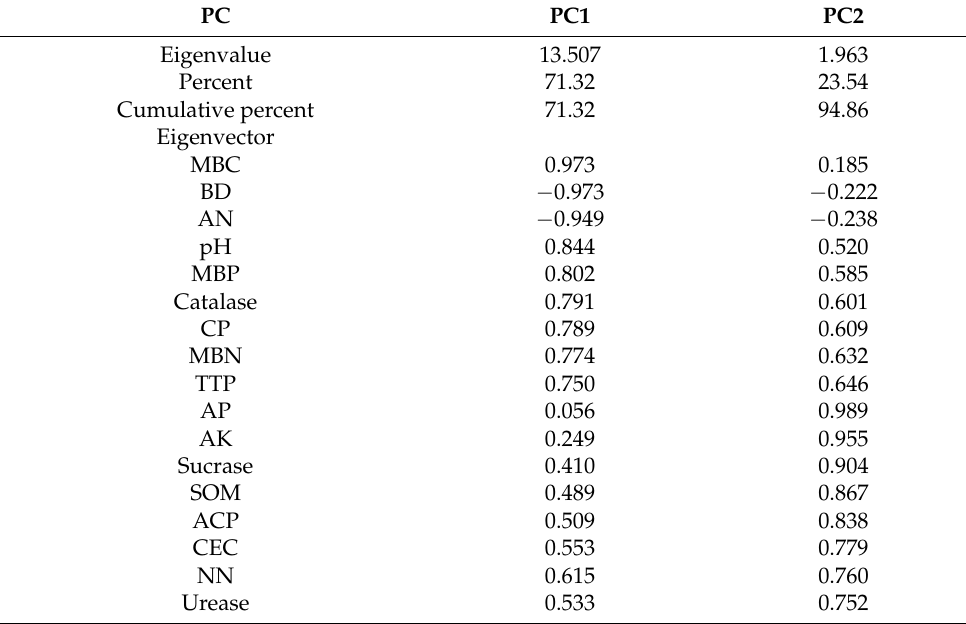
Table 6. Results of principal component analysis of soil quality indicators in IDS.